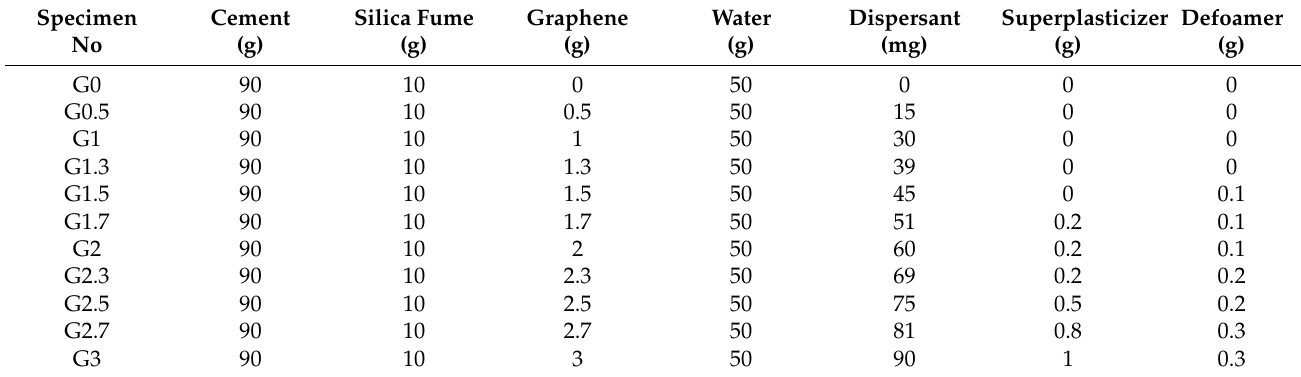
Table 5. Mix proportions of graphene-based cement